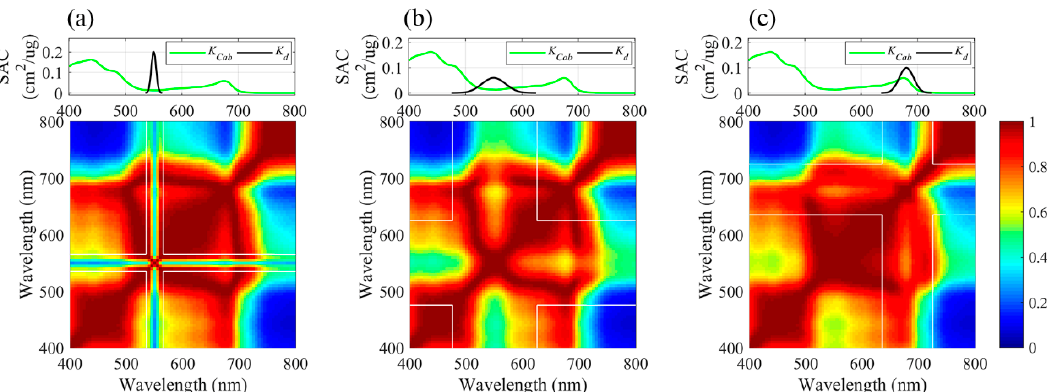
Figure 5. Correlation coefficient maps of reflectance wavelength pairs from datasets simulated with different C d absorptions. ( a ) Absorption peak location at 550 nm with absorption peak value of 0.20 cm 2 /ug and half-width of 10 nm; ( b ) absorption peak location at 550 nm with absorption peak value of 0.06 cm 2 /ug and half-width of 50 nm; ( c ) absorption peak location at 680 nm with absorption peak value of 0.10 cm 2 /ug and half-width of 30 nm.